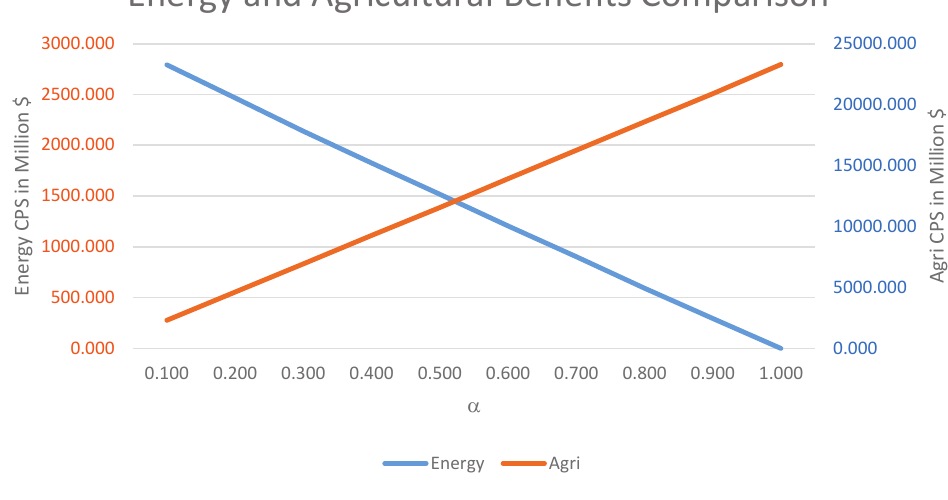
Figure 5. Impact of α on agriculture and